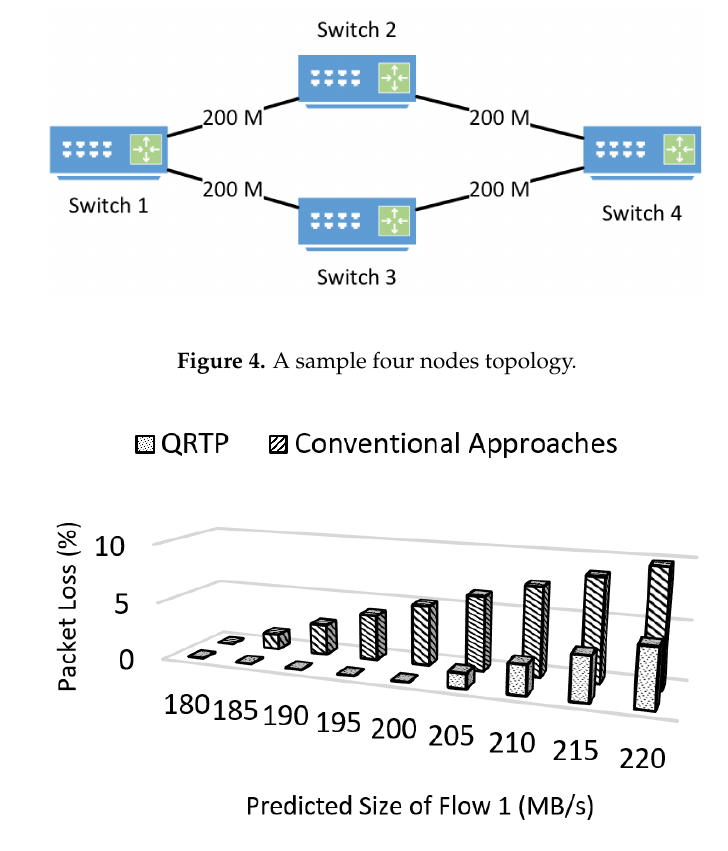
Figure 5. Prediction impact on packet loss. The impact of the proposed algorithm is more clear when the size of the traffic flows increases during the time (transmission control protocol (TCP) connections have similar